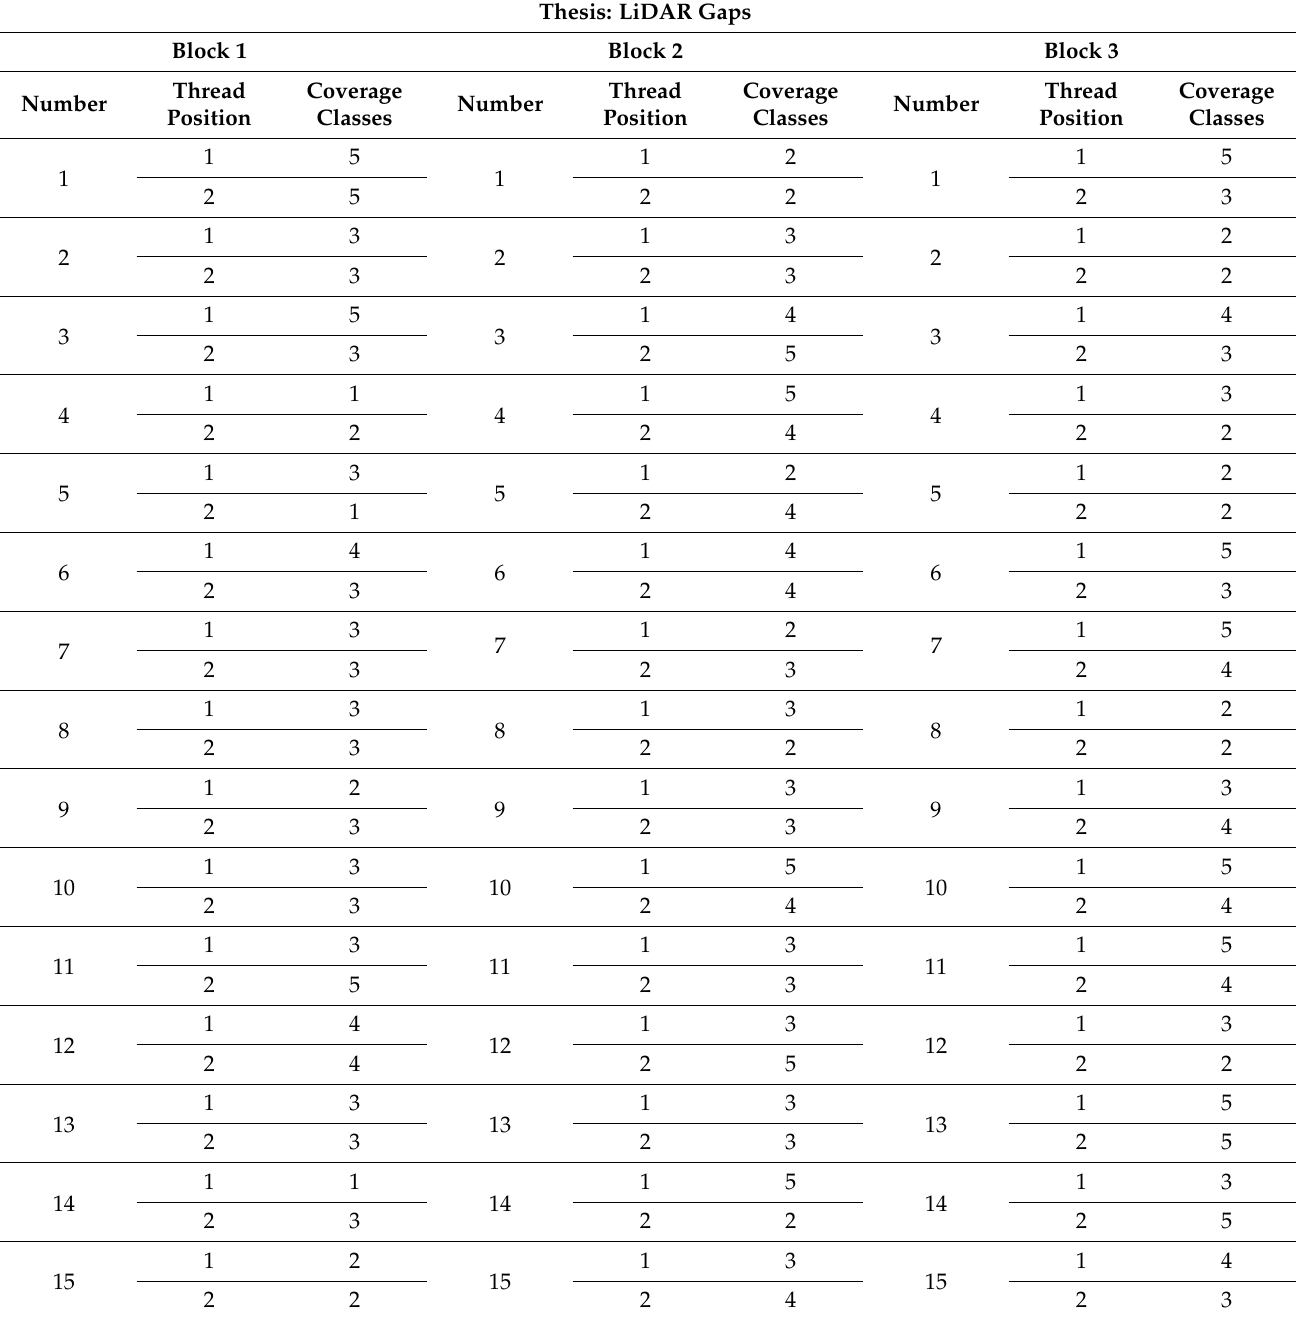
Table 3. Results of LiDAR tests on vine gaps: linkage of WSP coverage classes to each thread